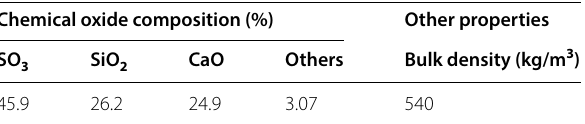
Table 2 Chemical oxide composition and other properties of polymer.